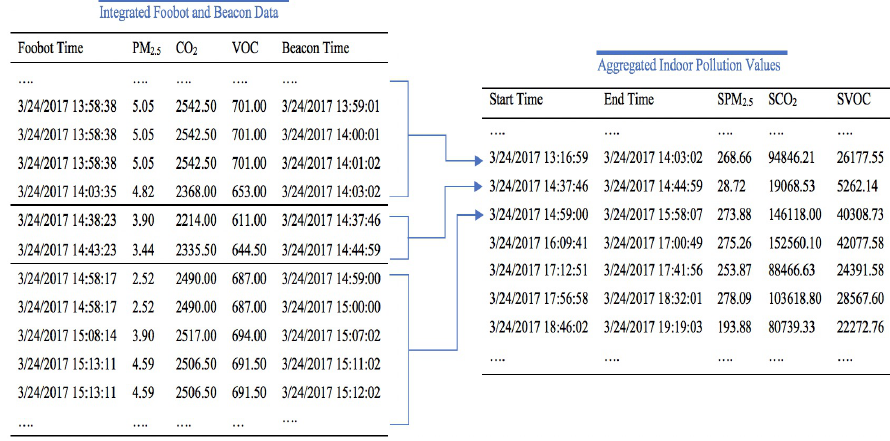
Figure 4. Aggregation of Indoor Pollution